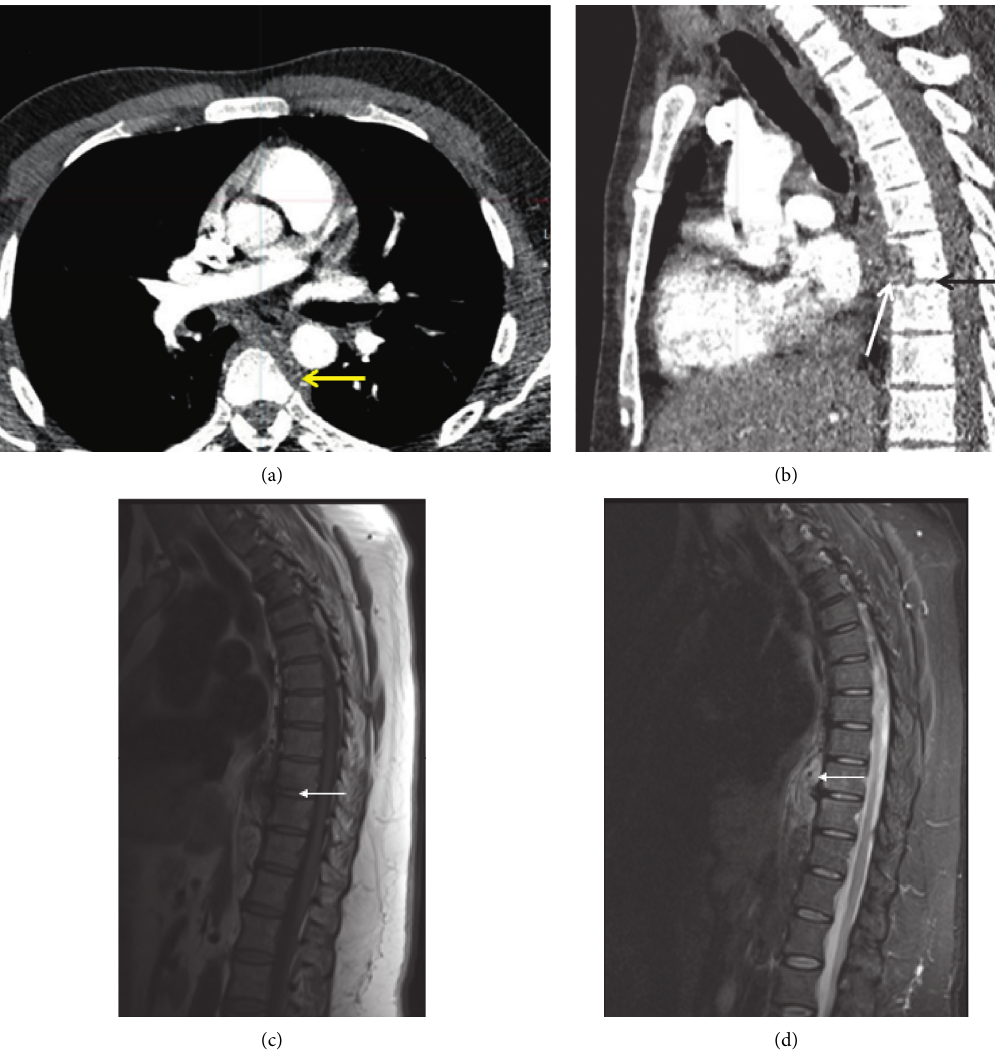
Figure 4: Tuberculous osteomyelitis. Postcontrast axial (a) and sagittal (b) chest CTof a 34-year-old patient with biopsy-proven TB discitis- osteomyelitis. There is lytic destruction of the T7 vertebral body anteriorly ((b) white arrow). There is subligamentous soft tissue density extending from T5-T8 (A yellow and B white arrows) with relative sparing of the adjacent T7 end plates (b black arrow). Sagittal T1 (c) and STIR (d) of a different patient with T9/10 osteomyelitis (c arrow) and pronounced subligamentous spread of disease from T8/9-T11 (d arrow). Note the relative sparing of the disc in early disease (c